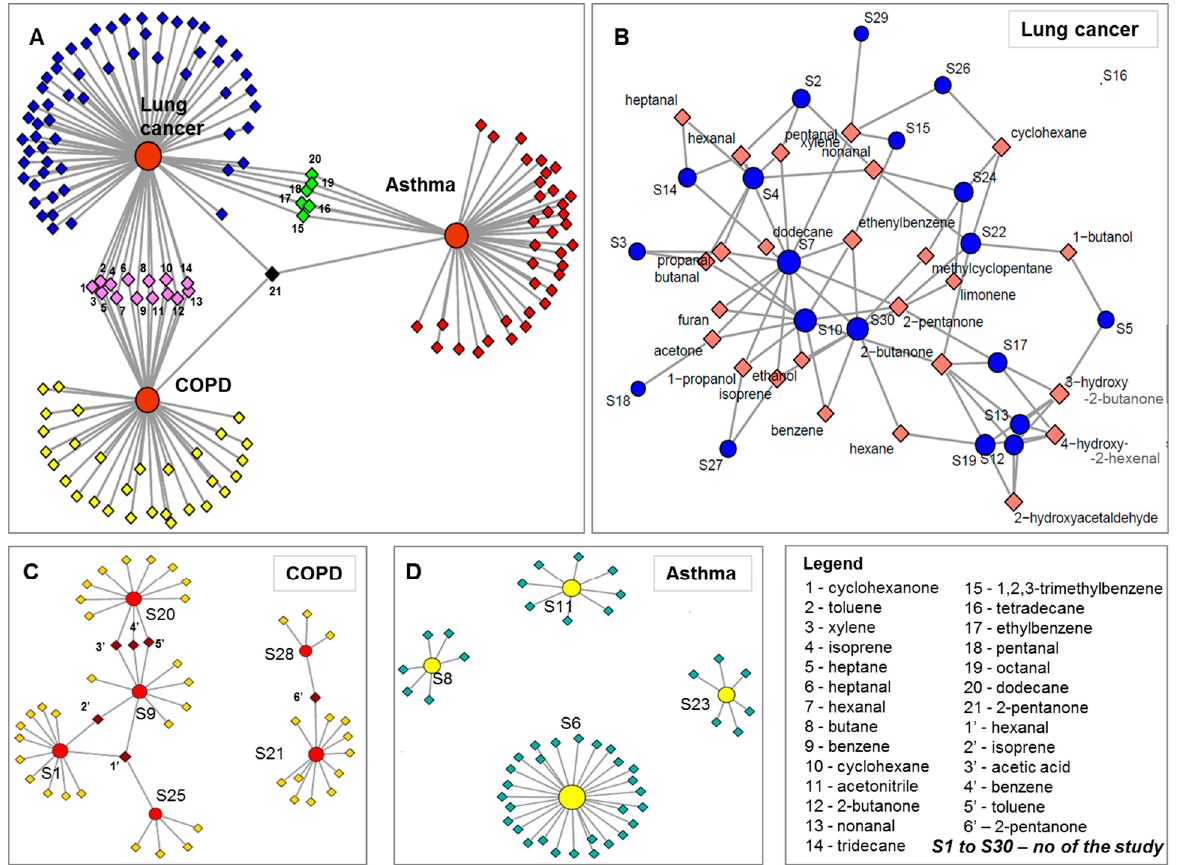
Figure 6. Network analyses presenting the distribution of VOCs between the three reviewed conditions (part ( A )) and highlighting volatiles common dispensation in case of lung cancer (part ( B )), COPD (part ( C )) and asthma (part ( C )). The circles noted with S (in part ( B – D )) represent number of the study, which are allocated similarly in Table 3, and the diamonds represent the components.